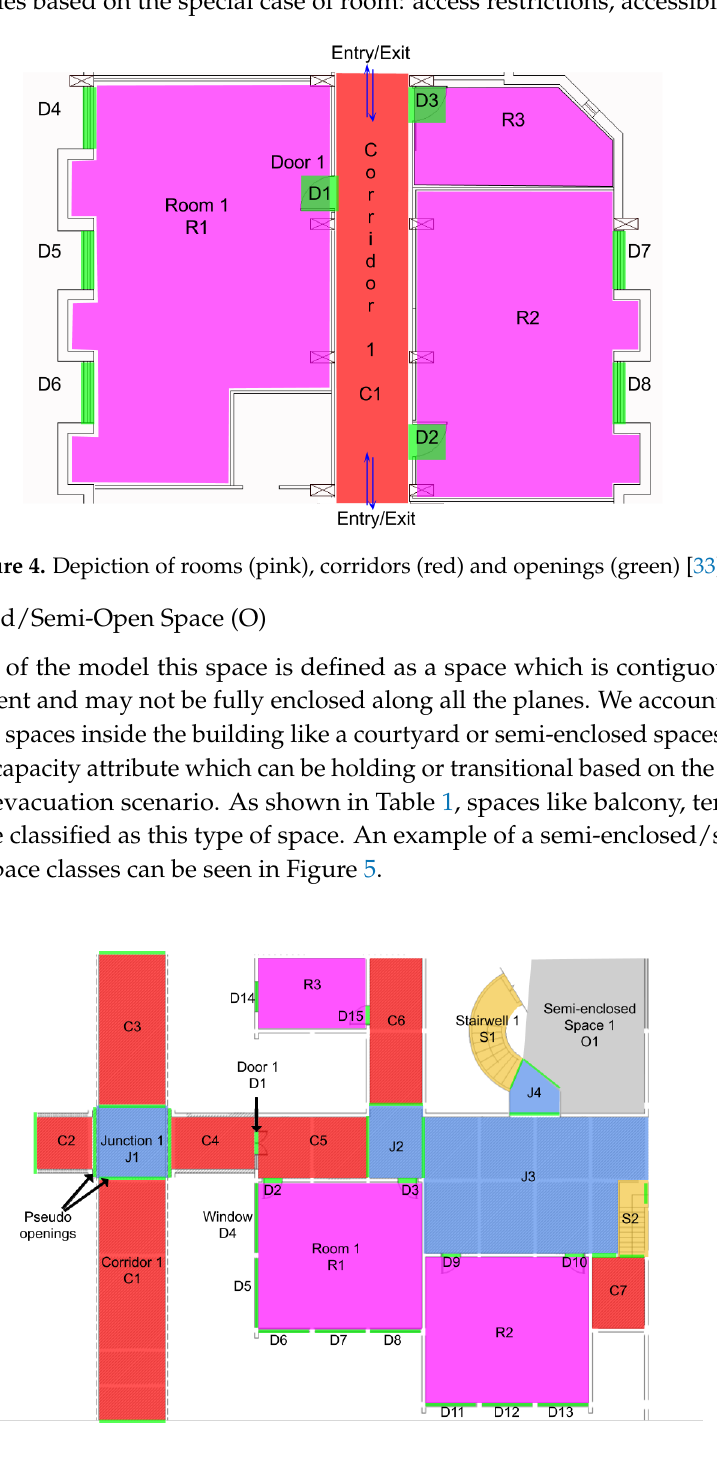
Figure 5. Depiction of classes defined for Standard and Connecting